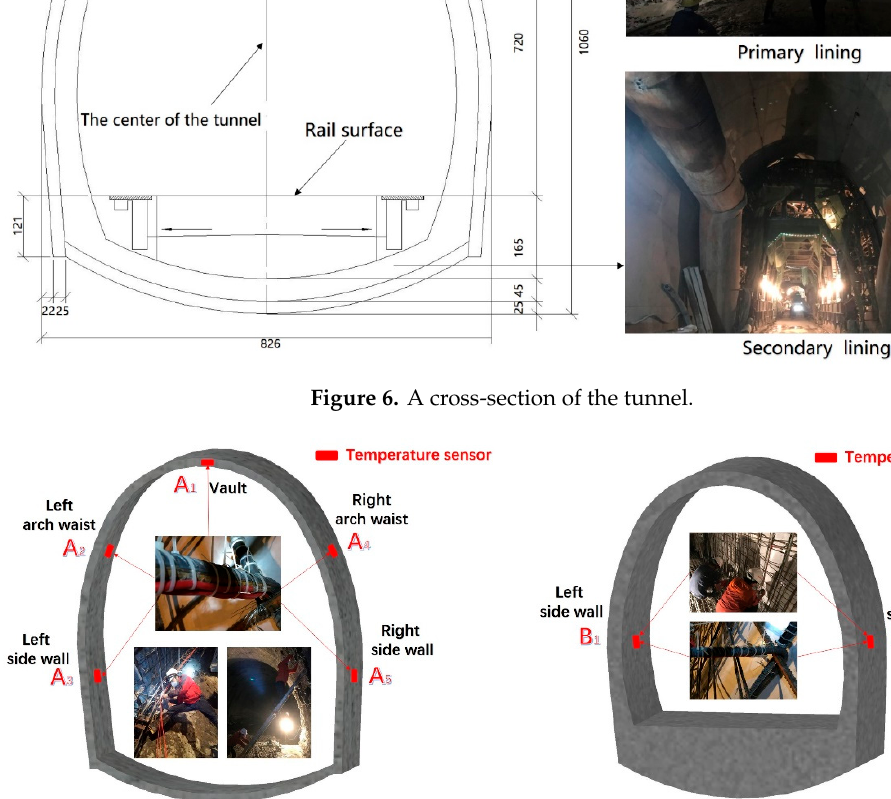
Figure 7. Layout of temperature monitoring points in lining structure: (a) primary lining and (b) secondary lining.